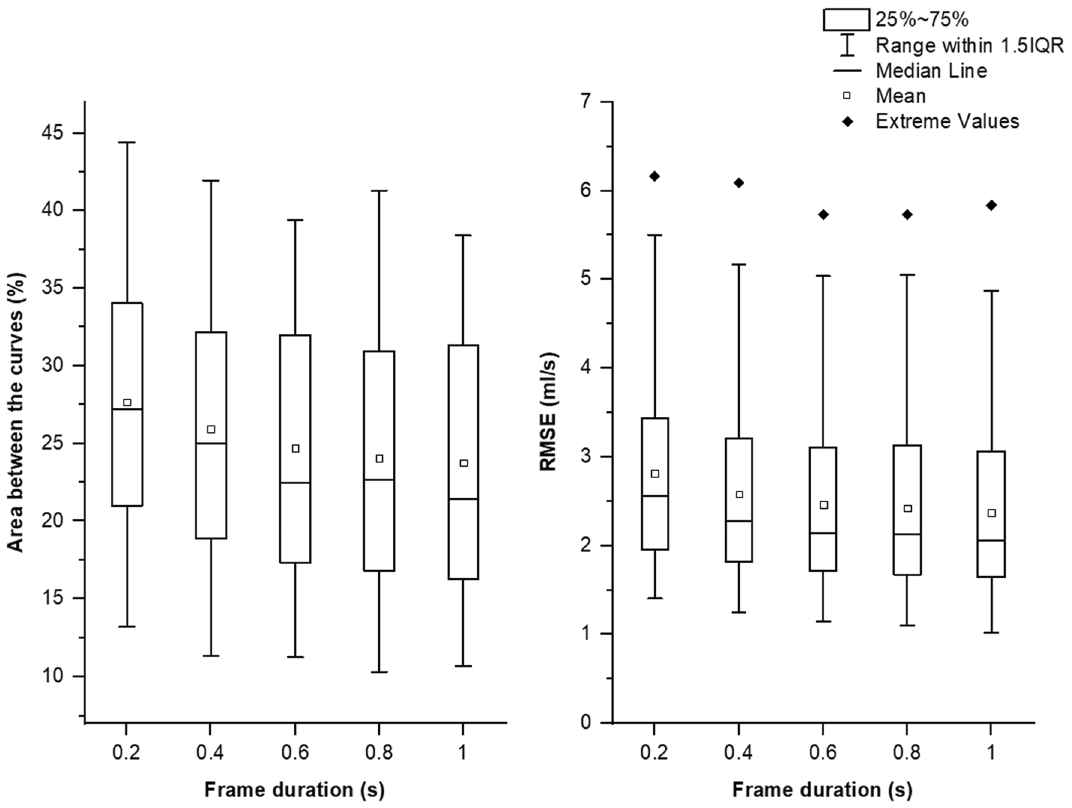
Figure 3. Comparison between the UF and SUF flow rate curves.